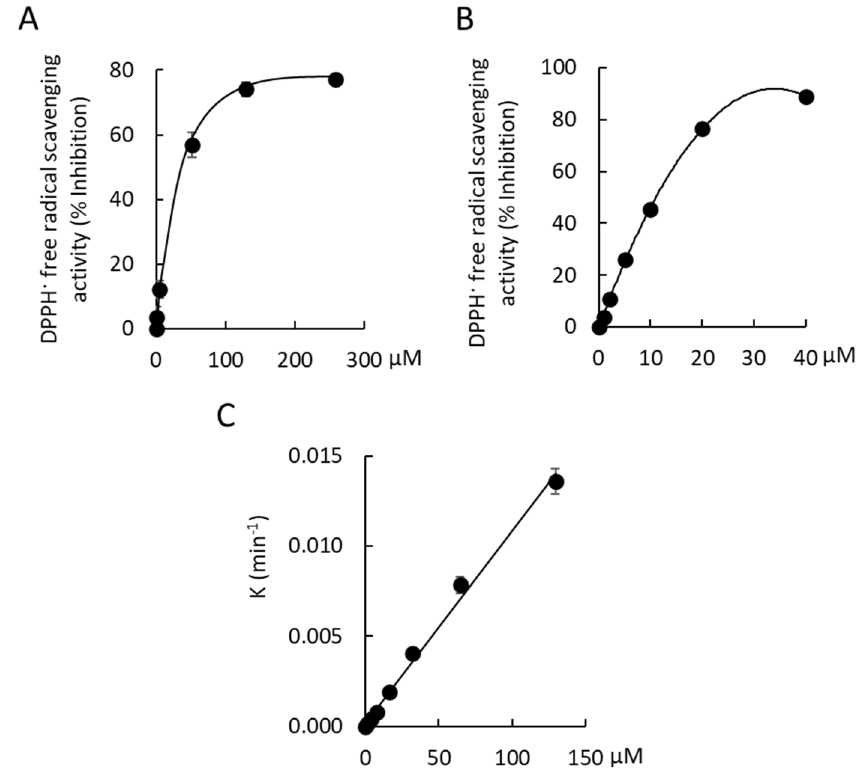
Figure 7. ( A ) 2,2-Diphenyl − 1 − picrylhydrazyl (DPPH · ) free-radical scavenging by Com- pound 1 in a cell-free assay. Maximal free radical scavenging activity by Compound 1 was 77.1 ± 0.9% at 259 µ M. The EC 50 value for free radical scavenging activity was 44.7 ± 3.1 µ M. ( B ) 2,2 − Diphenyl − 1 − picrylhydrazyl (DPPH · ) free-radical scavenging by gallic acid in a cell-free assay. Maximal free radical scavenging activity by gallic acid was 89.0 ± 0.2% at 40 µ M. The EC 50 value for free radical scavenging activity was 9.7 ± 0.5 µ M. ( C ) The radical scavenging capacity of ± SEM for n = 3 ( A , C ) and n = 6 ( B ) independent